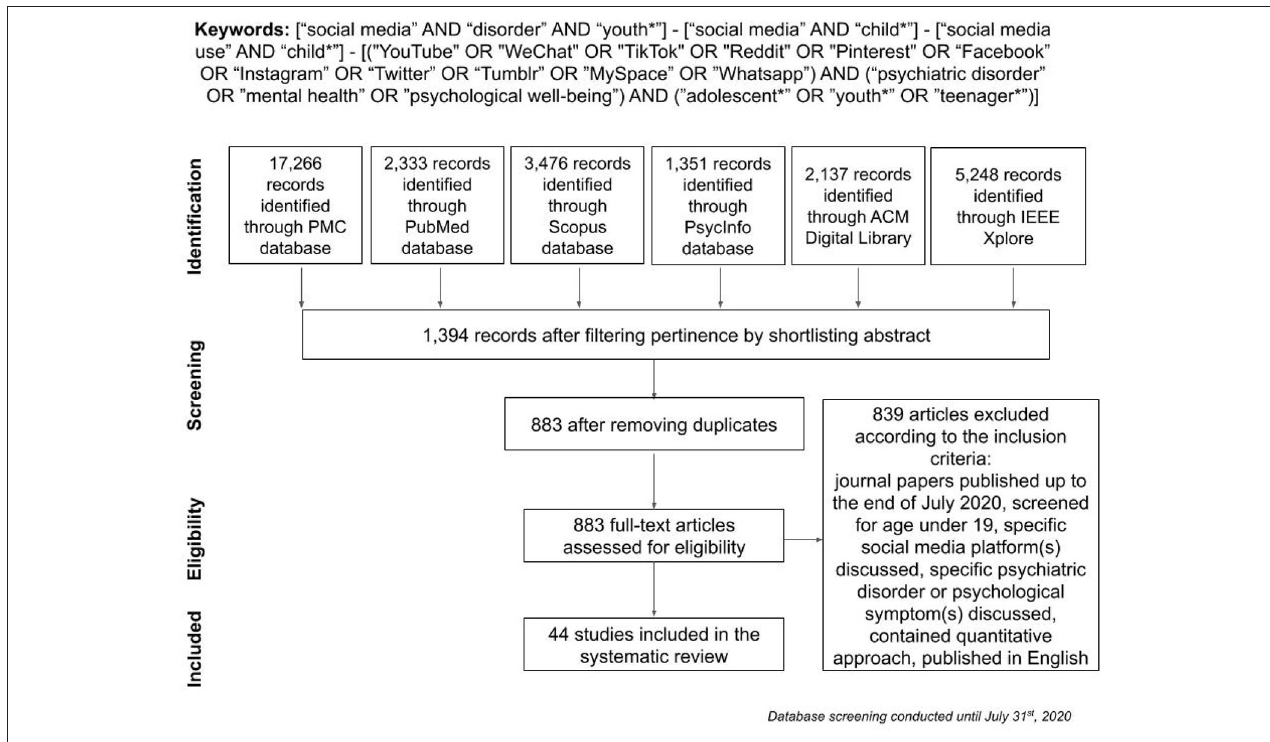
FIGURE 2 | Flow chart of procedural articles shortlisting according to the Preferred Reporting Items for Systematic reviews and Meta-Analyses (PRISMA)